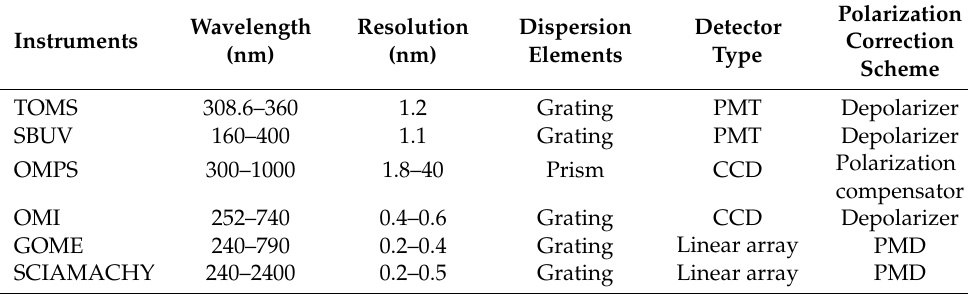
Table 1. Typical Atmospheric Ultraviolet Spectrometer Polarization Correction Scheme.